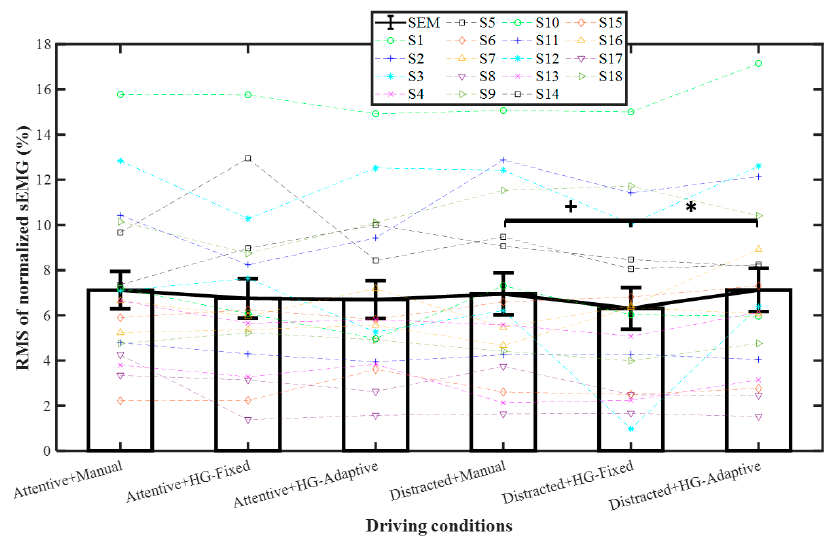
Figure 5. RMS of normalized sEMG (%). Mean +/ − SEM represented by error bars. + p < 0.1 and * p < 0.05.